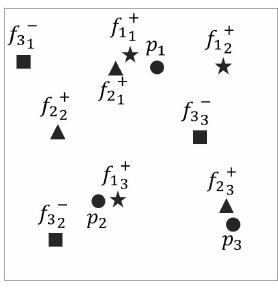
Figure 2. Some Facilities in a